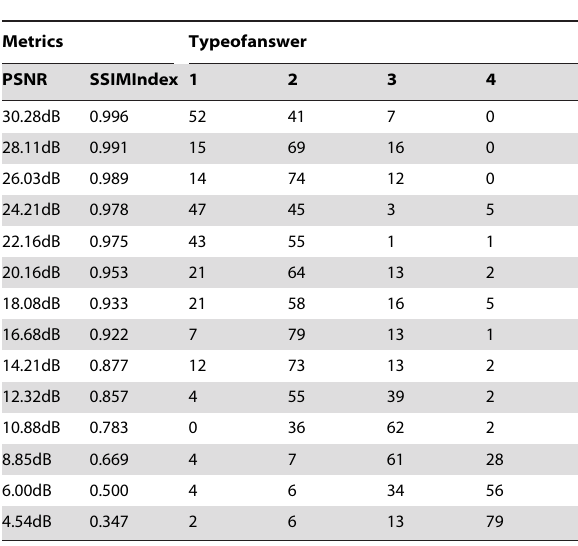
Table 2. Perception of respondents to fingerprinted documents with different PSNR and SSIM Index